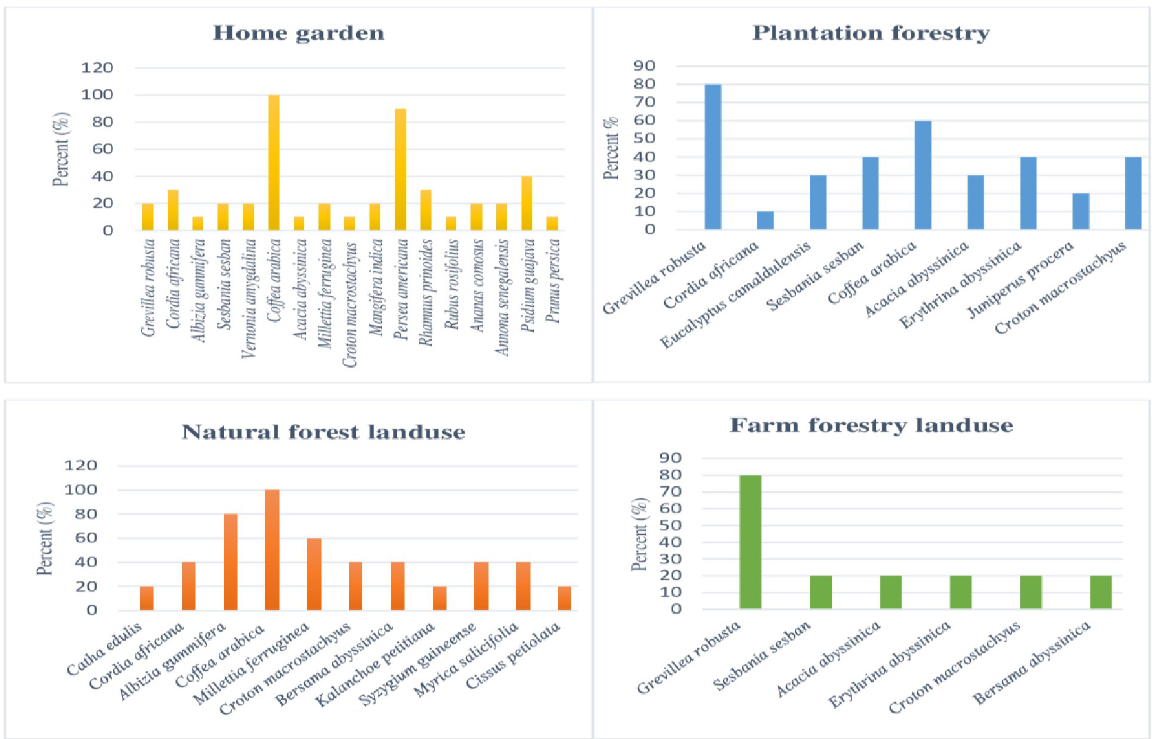
Fig 3. Home garden, plantation, natural forest and farm forestry land use species diversity in the Somodo Watershed.